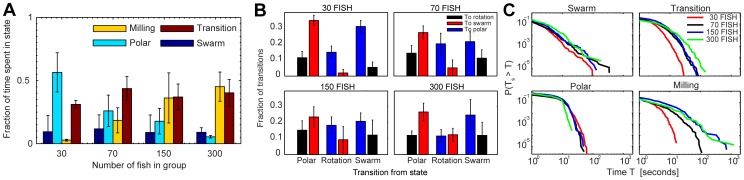
Statistics of state transitions.(A) Fraction of time spent in the different dynamical states shown for each group size. The error bars are showing the standard deviation measured across replicates. The group of 30 fish is predominantly in the polarized state, but less time is spent in this state with increasing group size (GLM: F1,22 = 36.21, P = 4.6e-06). As the group size increases, the groups gradually spend more time in the milling state (GLM: F1,22 = 19.31, P = 0.00023). The amount of time spent in the transition regime is high, but constant, for all group sizes (GLM: F1,22 = 0.67, P = 0.42). Across all group sizes (GLM: F1,22 = 0.053, P = 0.82) little time is spent in the swarm state. (B) Fraction of transitions from one state to another for the different groups. The error bars are showing the standard deviation measured across replicates. For all group sizes, the polar state predominantly transitions into the swarm state compared to the milling state (GLMM: F1,23 = 58.77, P<0.0001). The swarm state is dominated by transitions into the polarized state (GLMM: F1,23 = 55.69, P<0.0001). Although these transitions are consistent across group sizes, there is a significant interaction between group size and the frequencies of transitioning from the milling state to the swarm and polarized states (GLMM: F1,22 = 13.30, P = 0.0014). While the milling state tended to transition into the polar state, for 300 fish there was a roughly equal probability of transitioning to the polar or swarm states. (C) Rank plots showing the probability of being in a state longer than time Ts before moving into a different regime. There was no significant difference between group sizes in the persistence of the polar state (GLMM: F1,22 = 0.58, P = 0.45), although group size increased the persistence of the transition (F1,22 = 24.52, P = 1e-04) and milling states (F1,22 = 17.54, P = 4.0e-04), and to a lesser degree, the swarm state (F1,22 = 5.31, P = 0.031).